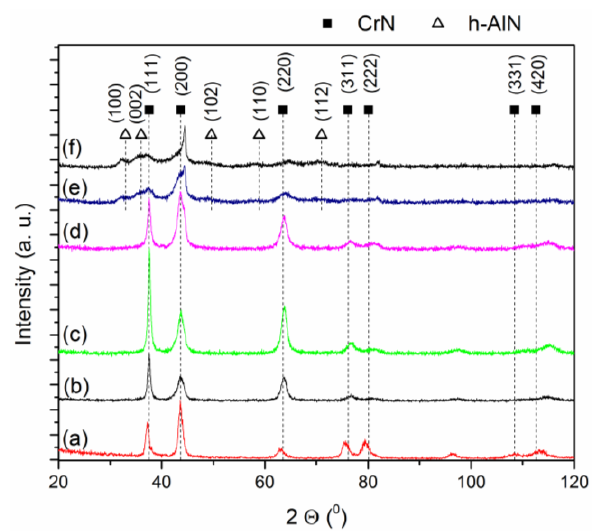
Figure 3. X-ray diffraction (XRD) patterns of CrN ( a ) and AlCrSiN coatings formed from cathodes with silicon concentrations: ( b ) 0 at%, ( c ) 1 at%, ( d ) 2 at%, ( e ) 5 at% and ( f ) 10 at%.